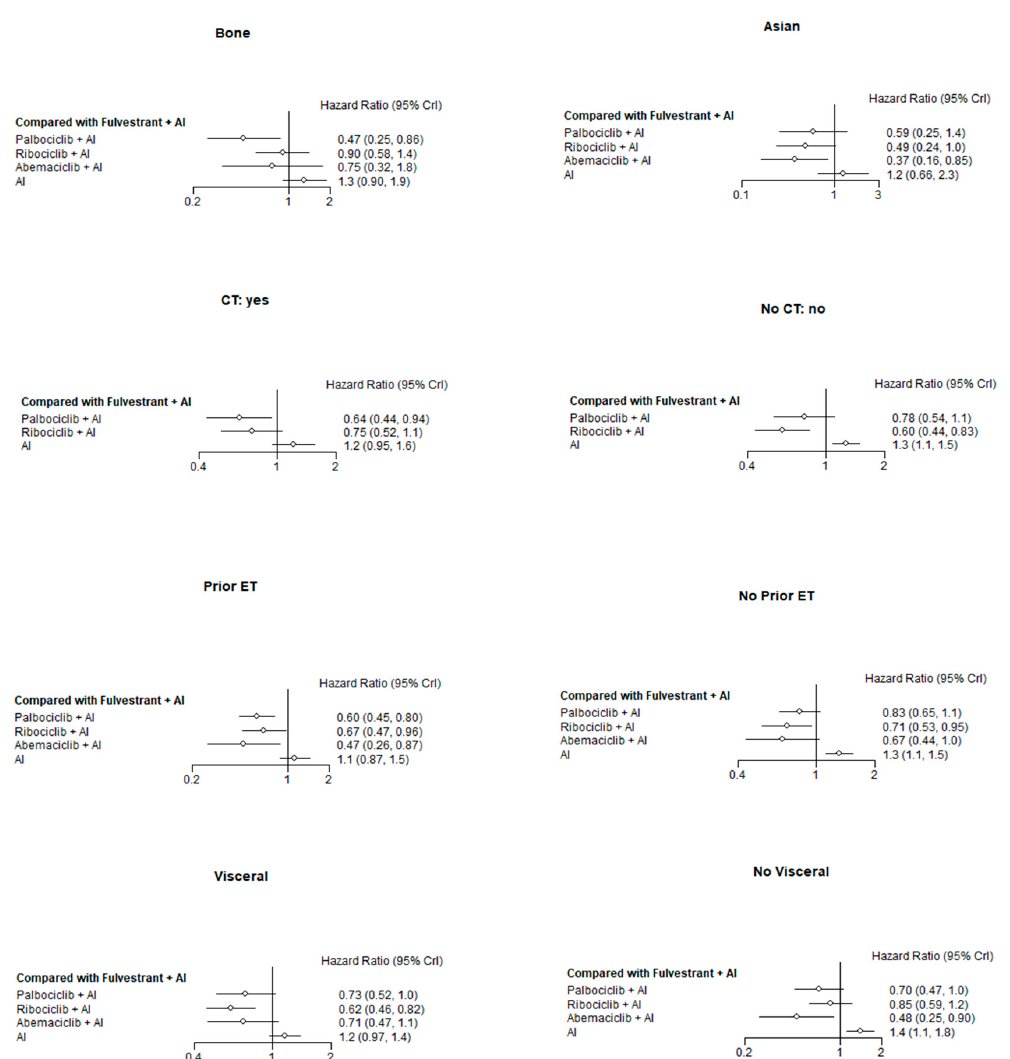
Figure 4. Forest plot on treatment effect for progression-free survival by subgroups in the indirect comparison between CDK 4/6 inhibitors, aromatase inhibitors, and fulvestrant. AI: Aromatase inhibitor; CT: Chemotherapy; ET: Endocrine therapy.